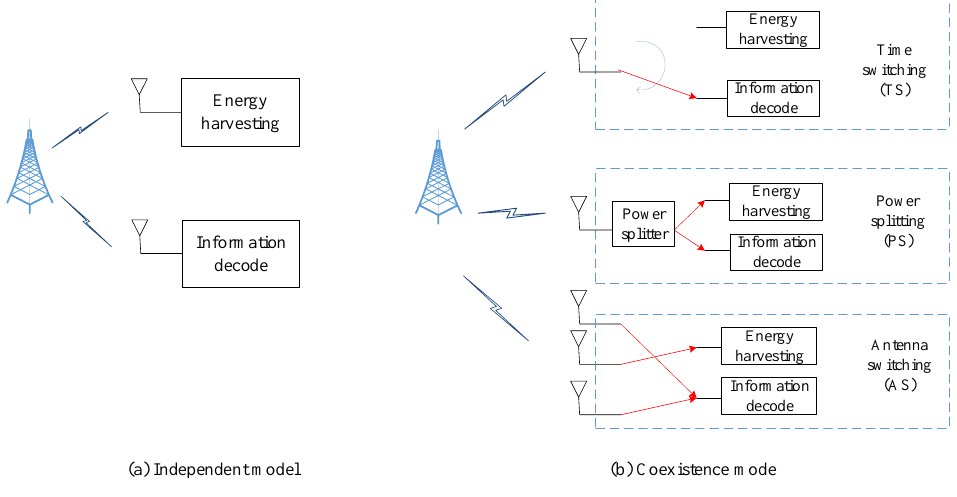
Figure 1. Illustration of SWIPT systems in independent and coexistence